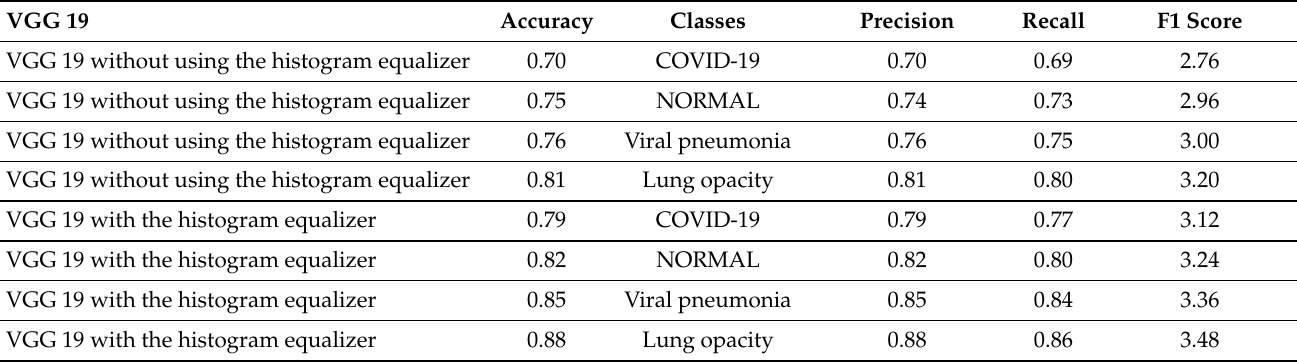
Table 3. Results of accuracy classification and algorithm evaluation for VGG-19.